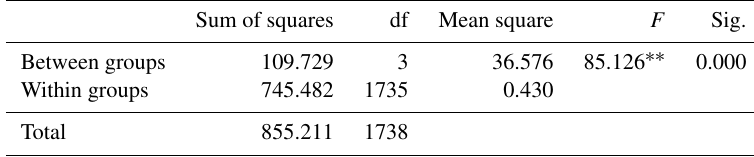
Table 2. Tables of analysis of the variance between degradation severity and different ecosystem types.